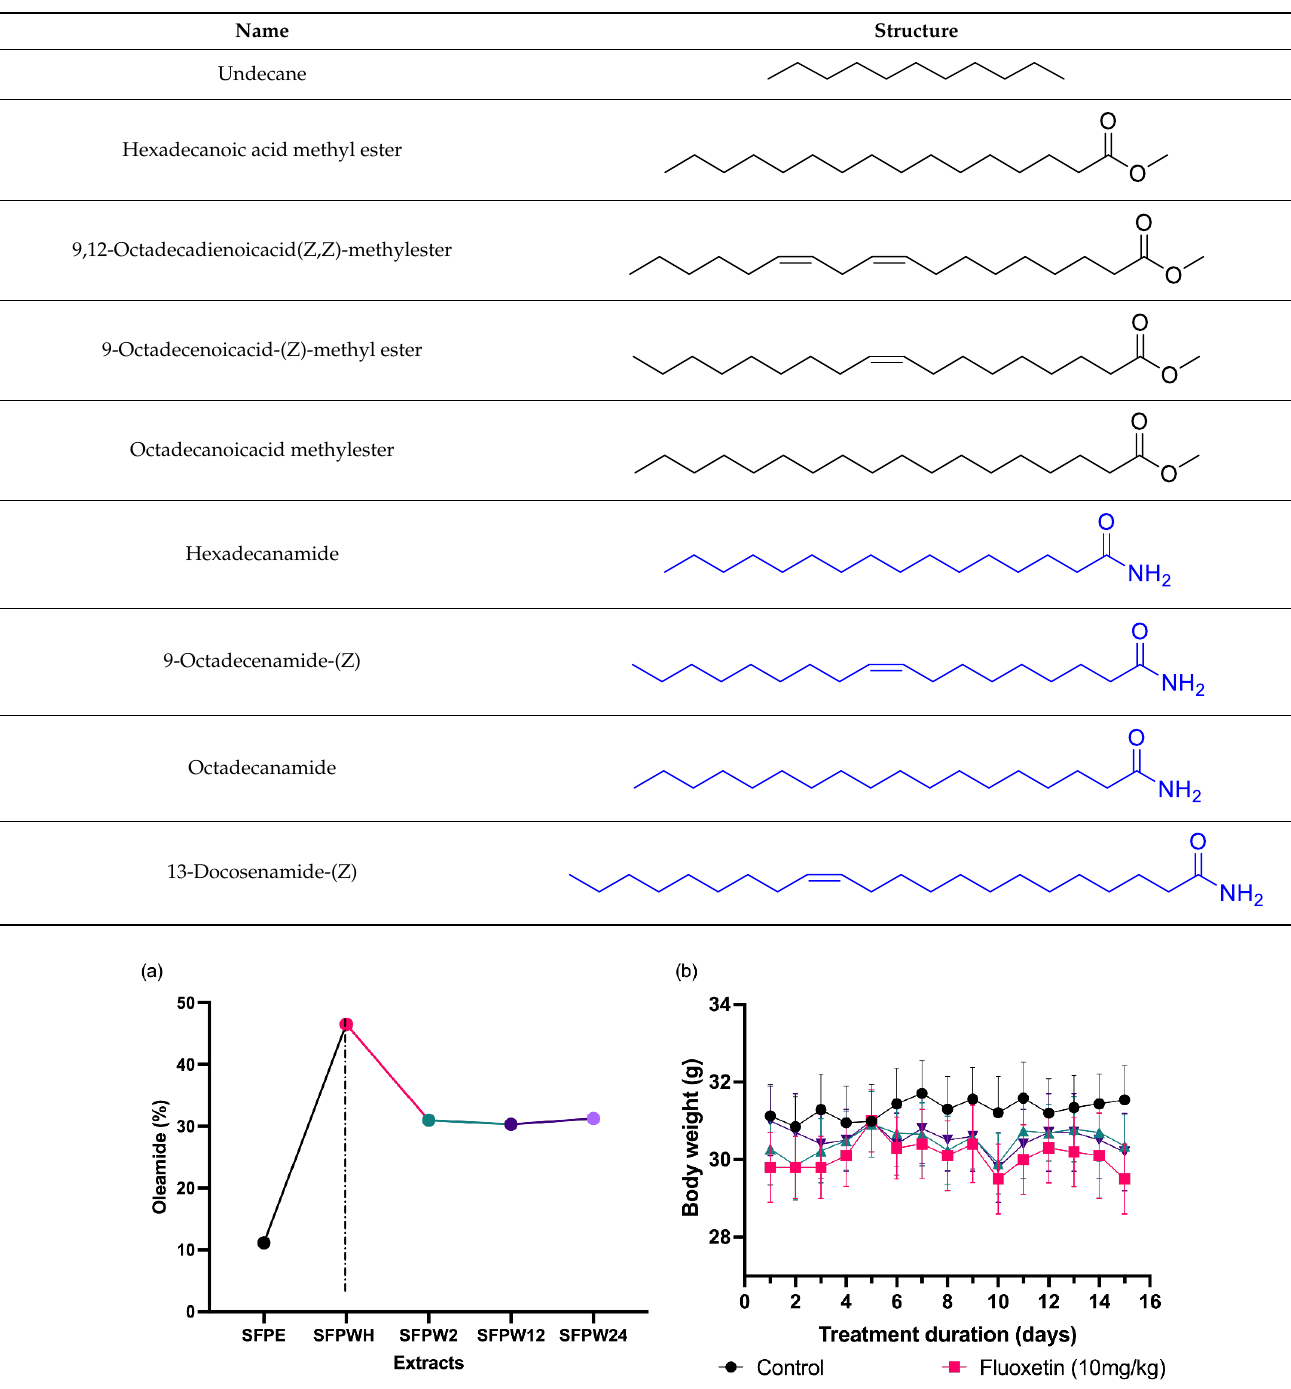
Table 1. Major chemical constituents present in Carthamus tinctorius hot water extract (detailed profiling refer to Table S1).